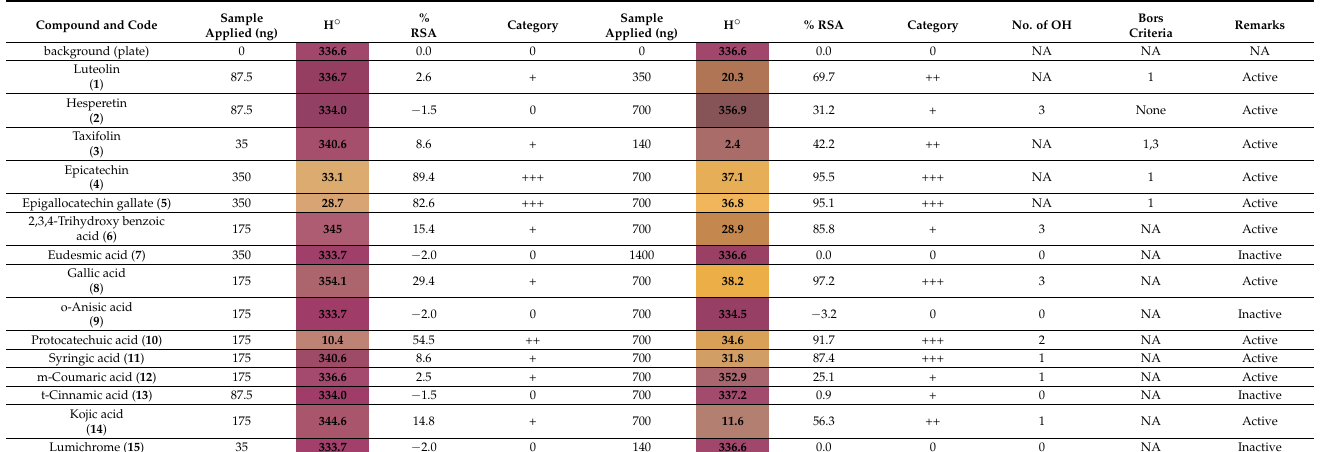
Table 9. Colour and % DPPH RSA of matched compounds at a higher and lower application volume (Note: See Table 3 for Antioxidant Category and